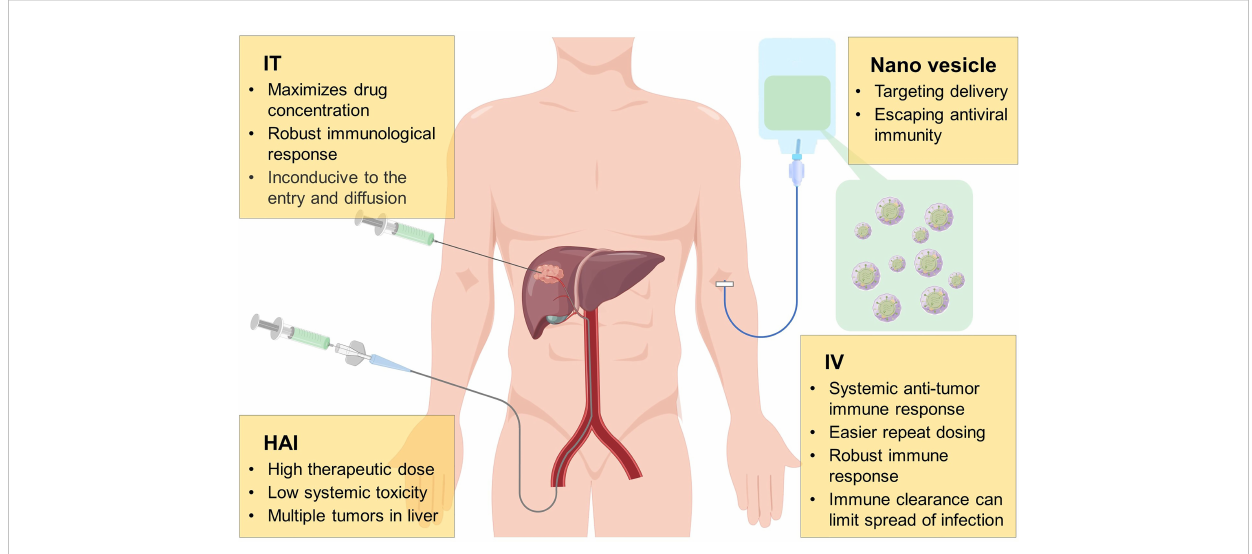
FIGURE 2 Mode of administration of oncolytic virus. During the development of oncolytic virus, many drug delivery routes have been investigated, including hepatic arterial infusion (HAI), intratumoral (IT), intravenous (IV) injection, of which each method has its own advantages and disadvantages. Anti-viral immune escape and tumor targeting by wrapping oncolytic virus with nano vesicles may be a more potential delivery method in the